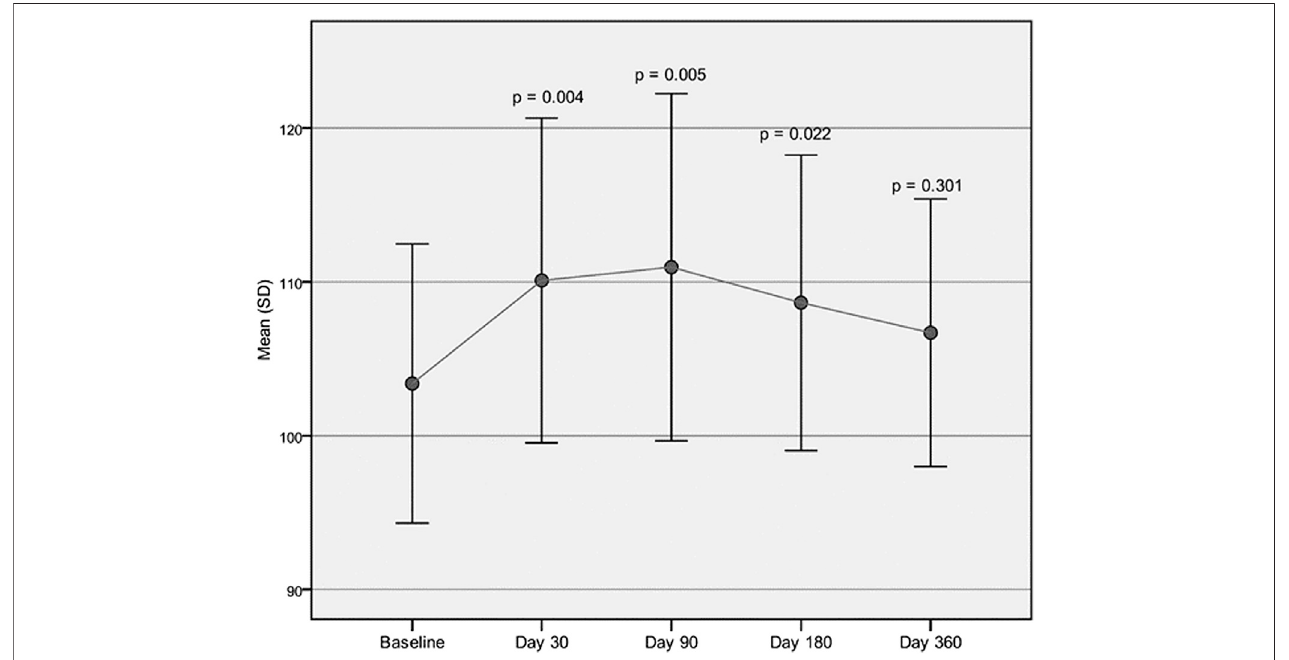
FIGURE 1 | Cadence assessed through GAIT analysis. Mean cadence (step/min) at baseline compared to the mean cadence recorded at each follow-up visit.